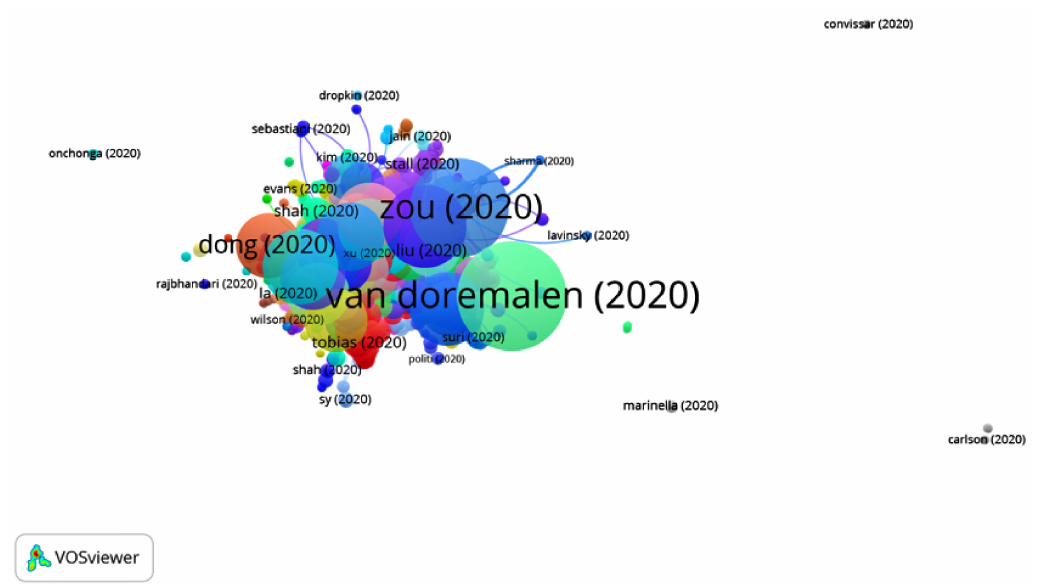
Figure 18. Citation network from the sub-clusters of Group